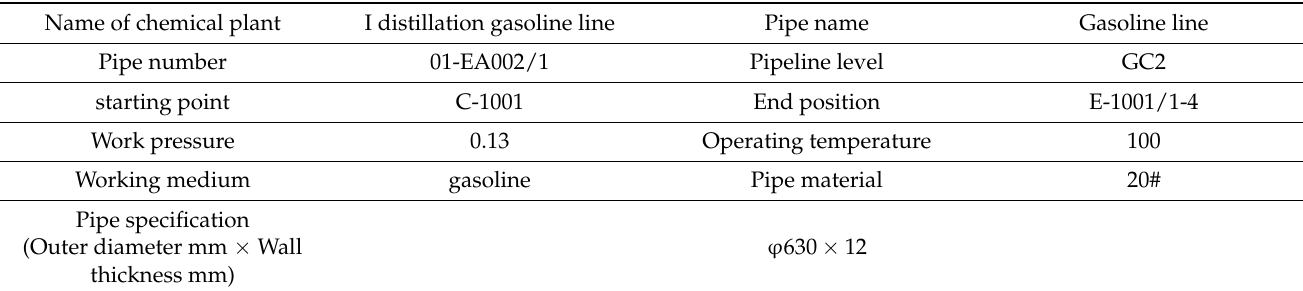
Table 8. The parameters of the pipe fittings of 01-EA002/1.